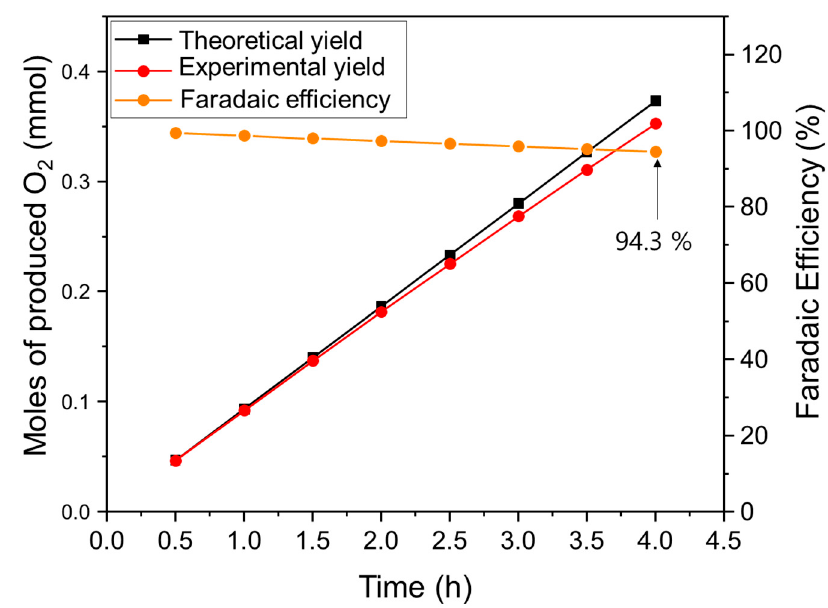
Figure9. Faradaice ffi ciencyofNi 0.75 Cu 0.25 Co 2 O 4 / GFforthetheoreticallycalculatedandexperimentally Figure 9. Faradaic efficiency of Ni 0.75 Cu 0.25 Co 2 O 4 /GF for the theoretically calculated and measured O 2 at a current density of 10 mA cm − 2 experimentally measured O 2 at a current density of 10 mA cm − 2 .